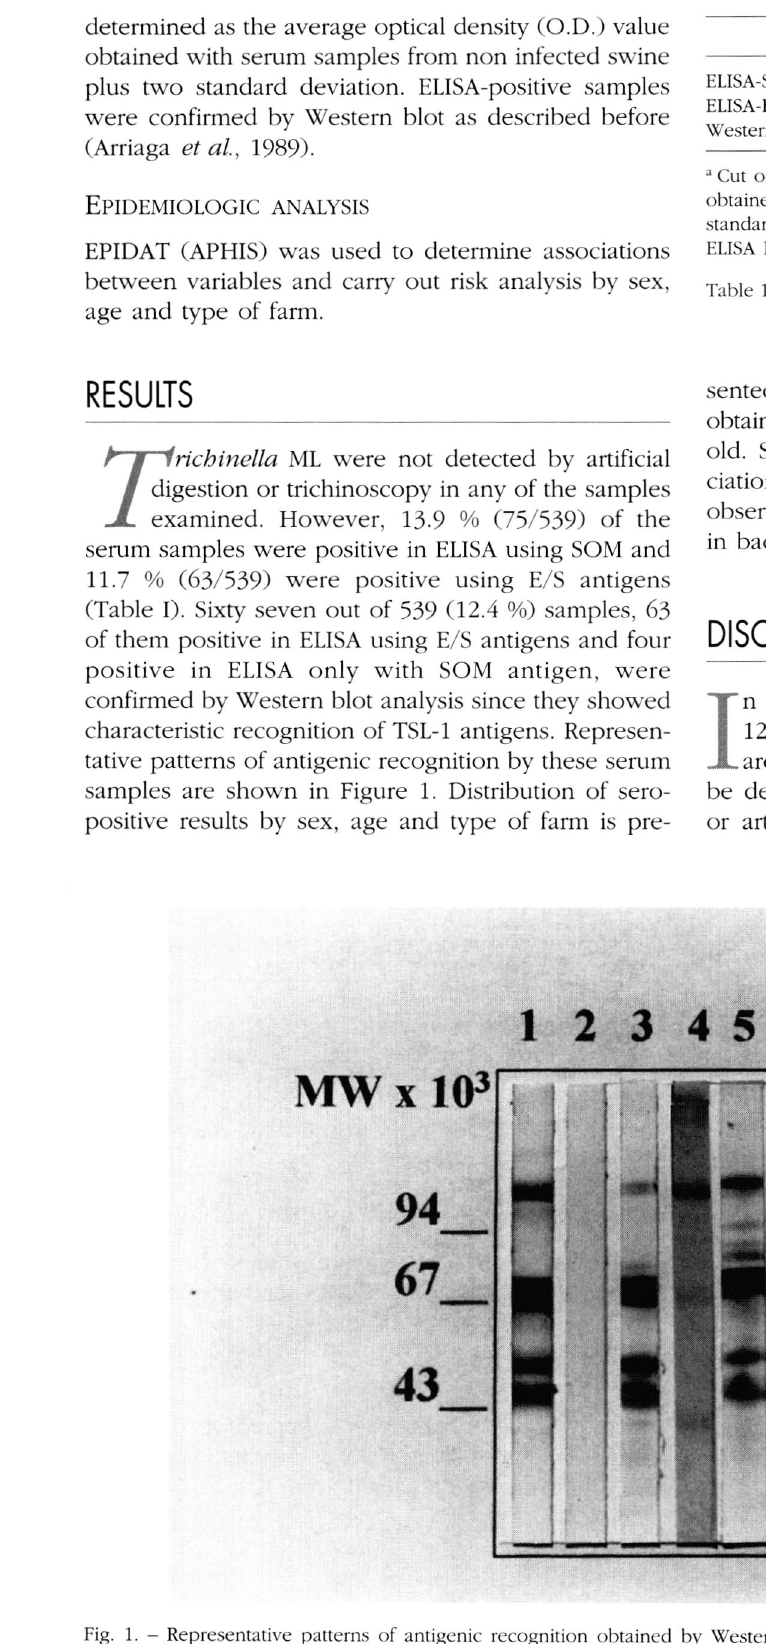
Fig. 1. - Representative patterns of antigenic recognition obtained by Western blot analysis with serum samples from slaughtered pigs. Lane 1: serum sample from experimentally infected swine. Lane 2: scrum sample from non infected control. Lanes 3-10: serum samples positive in ELISA using E/S